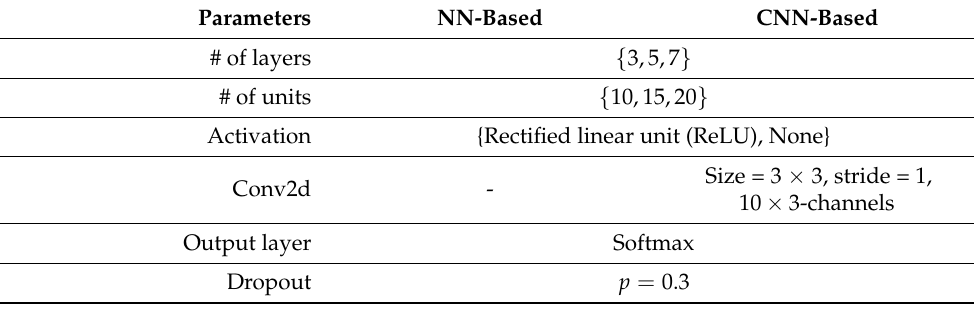
Size = 3 × 3, stride = 1, 10 × 3-channels